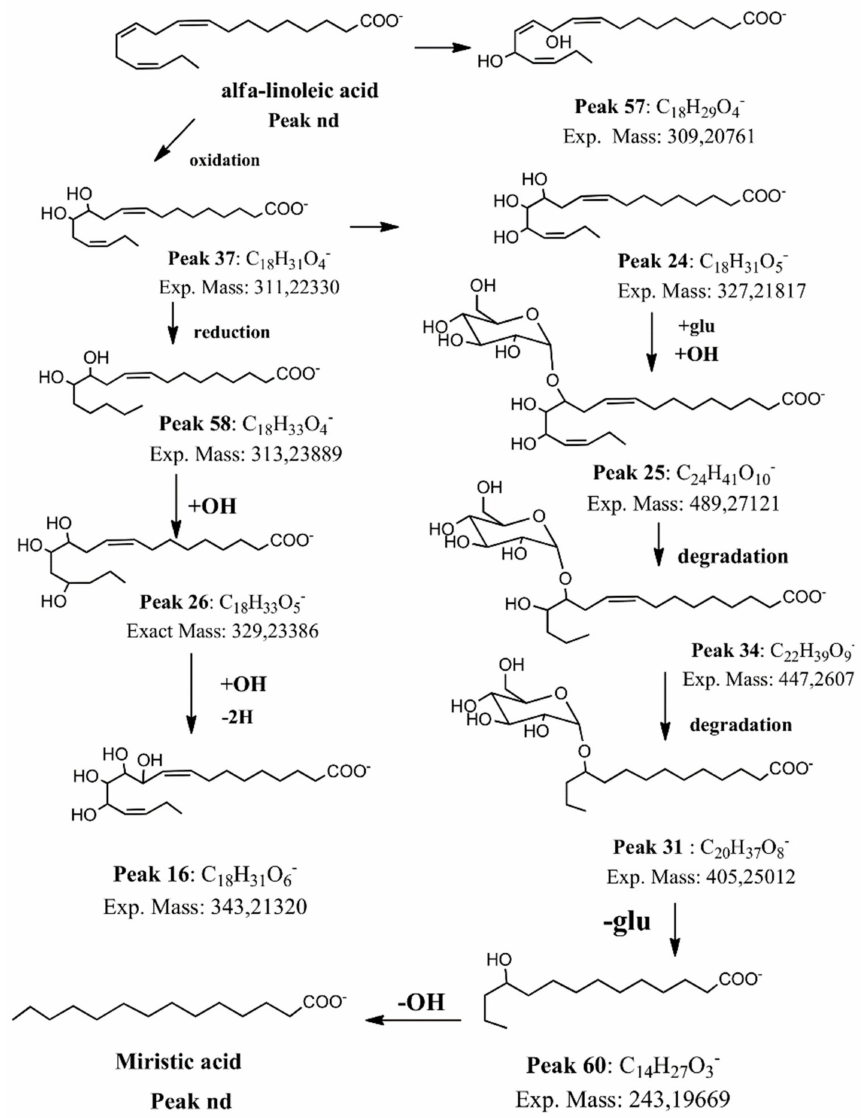
Figure 5. Biosynthetic relationship among fatty acids detected in N. ramosissima